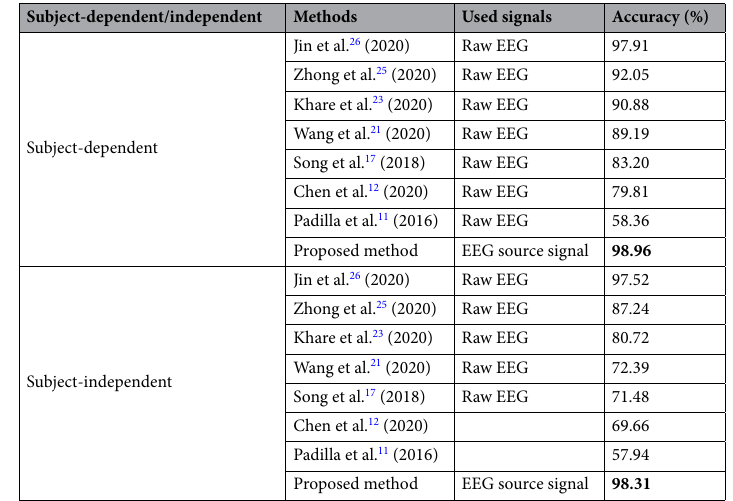
Table 4. Classification accuracy and details of the proposed method and deep neural network approaches which used raw EEG signals 11,12,17,21,23,25,26 for the DEAP dataset. Significant values are in bold.